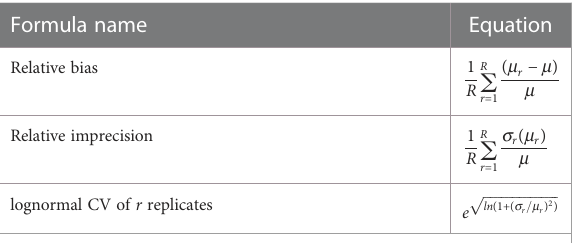
TABLE 1 Formulas used to compare relative bias and imprecision of glider sampling for R replicates at each maximum dive depth.